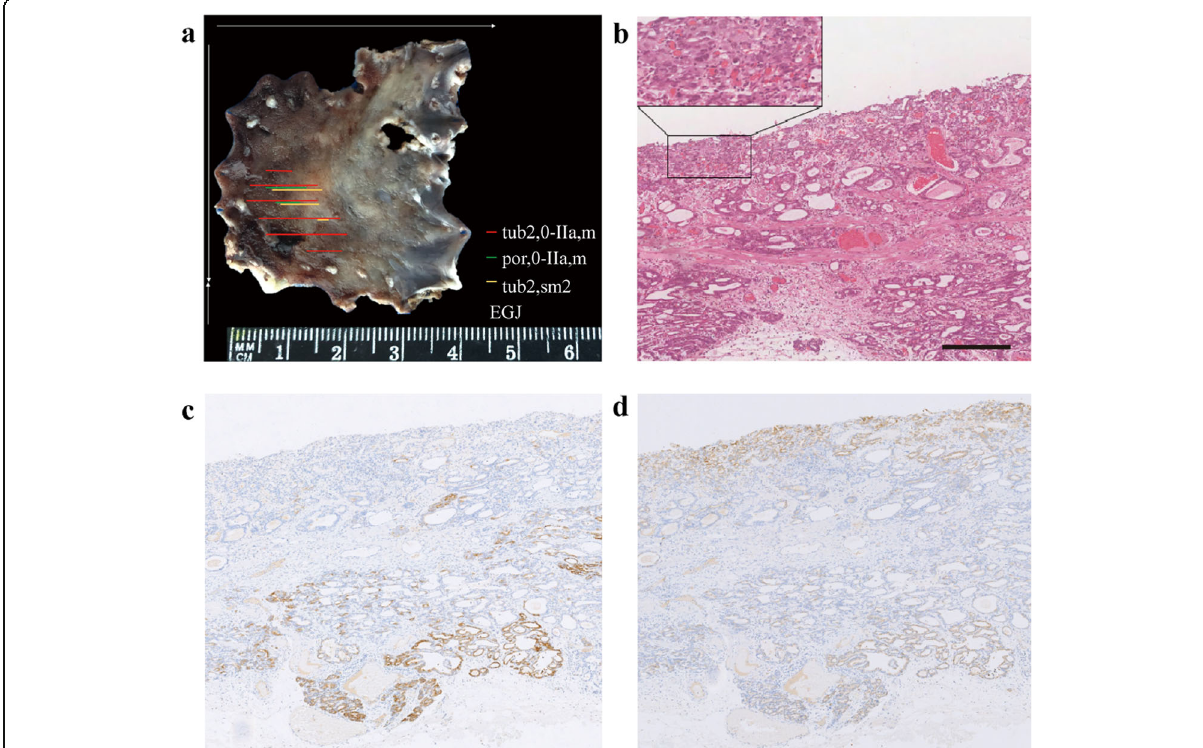
Fig. 4 Tubular adenocarcinoma mixed with poorly differentiated carcinoma showing the gastric mucin phenotype. Reconstructive map ( a ). H&E staining showing poorly differentiated carcinoma in the mucosa and tubular adenocarcinoma in the submucosa; the invasive depth is 2500 μ m ( b ). Positive staining for MUC5AC ( c ) and MUC6 ( d ), and invasive tubular adenocarcinoma showing MUC5AC ( c ) and MUC6 ( d ) positivity. (Scale bar =400 μ m, HE and IHC